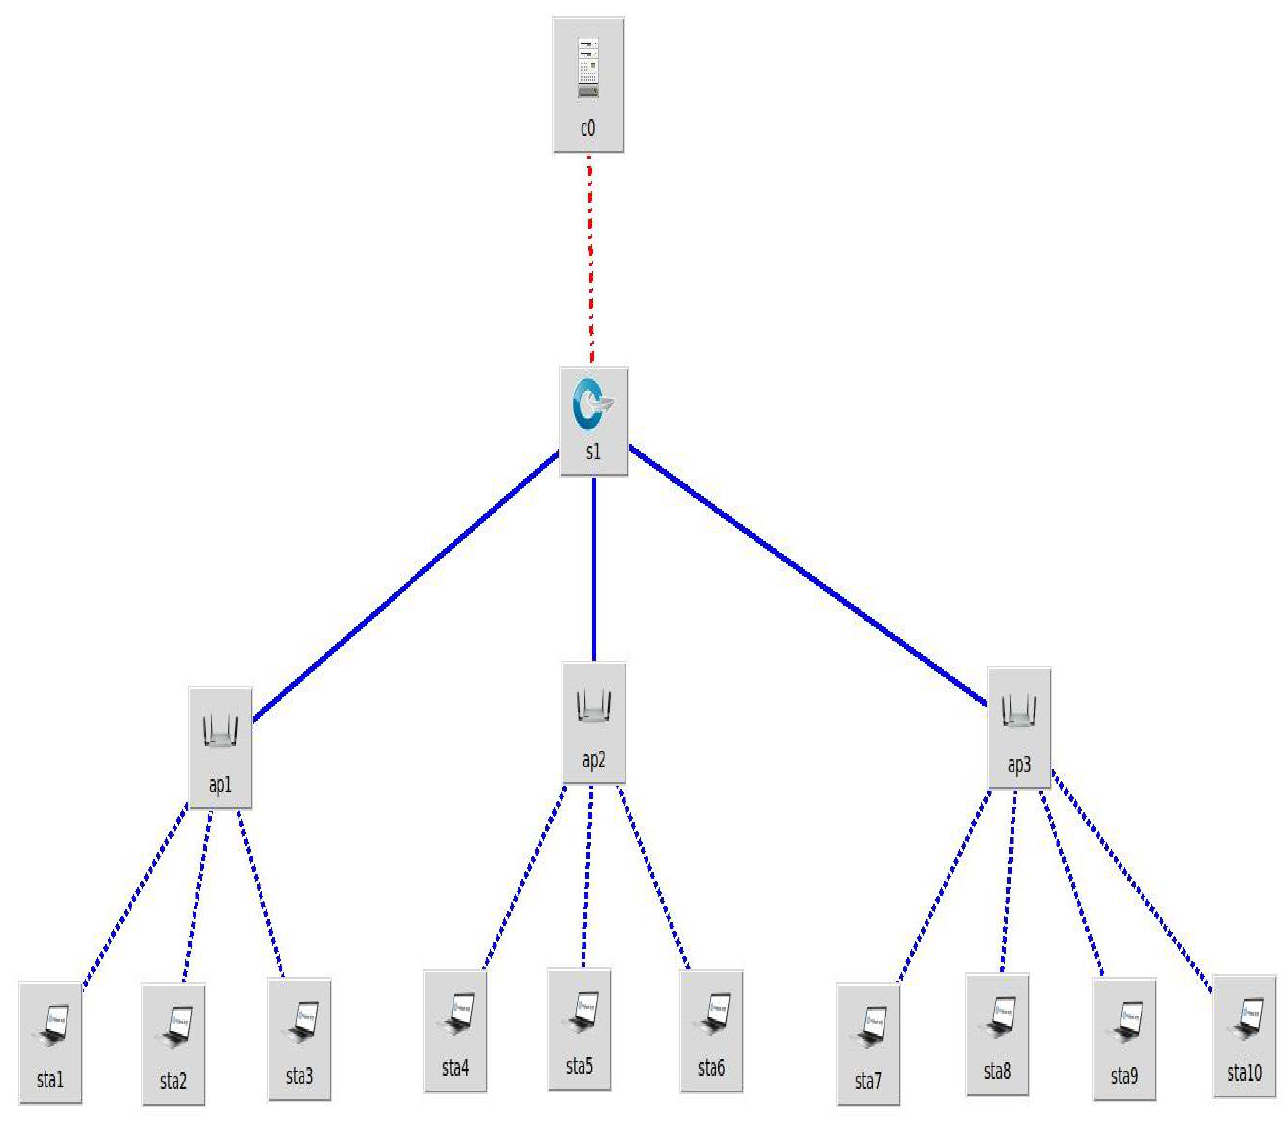
Figure 5. Custom tree topology.